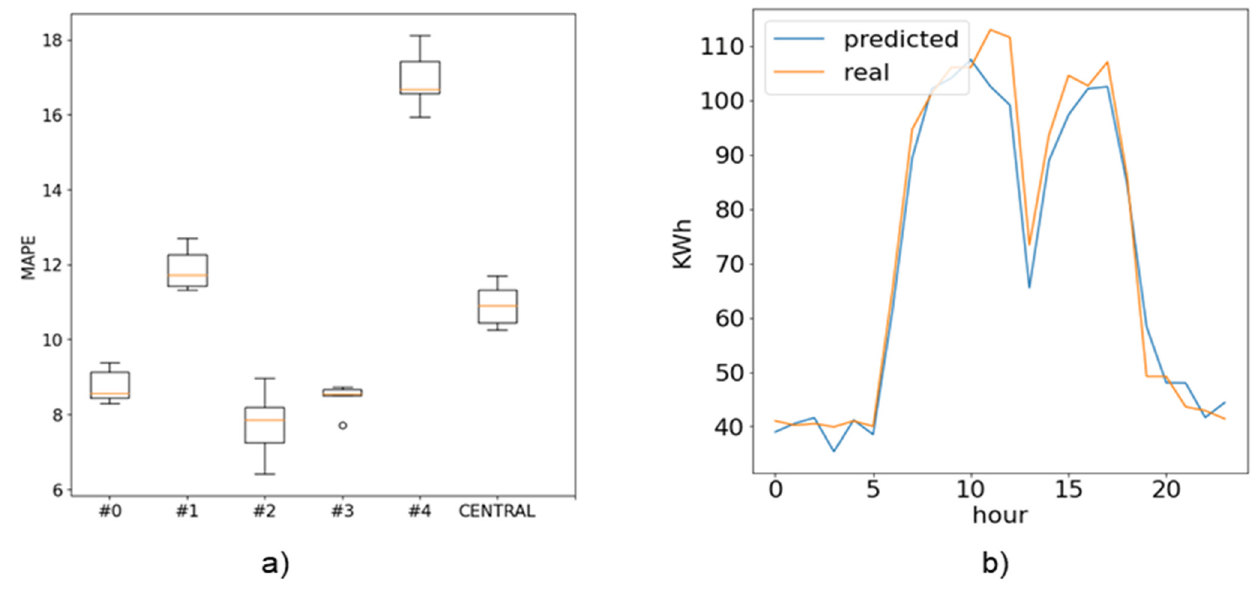
Figure 10. ( a ) Blockchain-based distributed FL model accuracy when trained with IID data. ( b ) Energy prediction for prosumer #3.